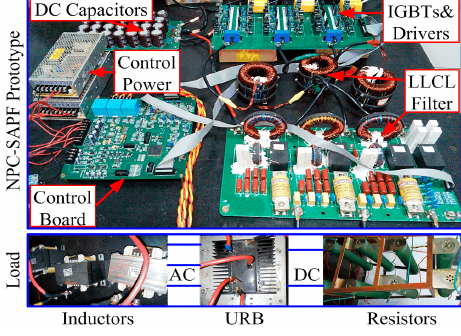
Figure 13. The 6.6 kVA NPC-SAPF system.